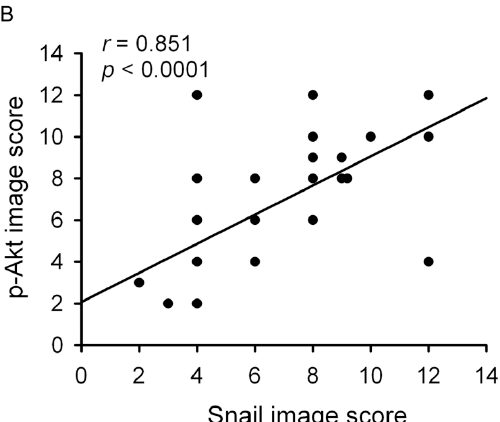
Figure 2. Phosphorylated (p)-Akt expression is positively correlated with Snail protein levels of patients with localized prostate cancer (PCa). ( A ) IHC staining analysis of p-Akt and Snail proteins in serial sections (200× magnification). Note the positive correlation of p-Akt and Snail protein expressions in tumor cells; ( B ) A significant positive correlation was observed between p-Akt expression levels and Snail expression levels (Spearman’s correlation coefficients: r = 0.851, p < 0.0001). Table 2. The association of phosphorylated (p)-Akt staining and clinicopathological features of prostate cancer (PCa) patients.